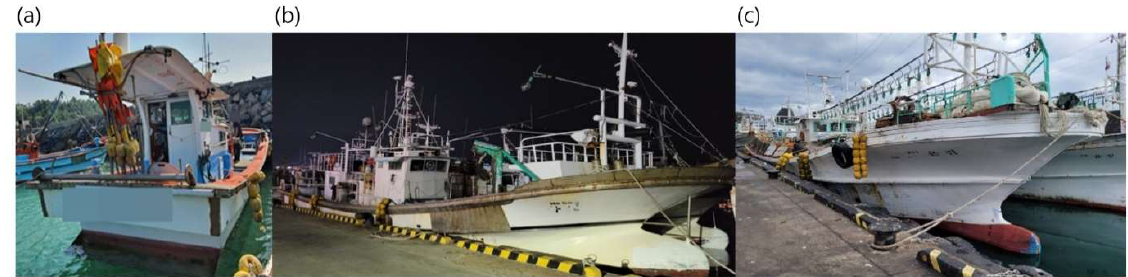
Figure 3. Reference fishing boats: ( a ) 4.99 tons, ( b ) 9.77 tons, and ( c ) 47 tons.